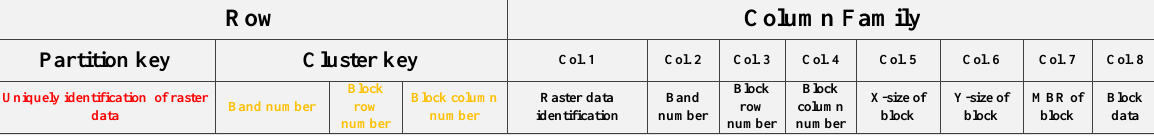
Figure 5. Structure of raster data